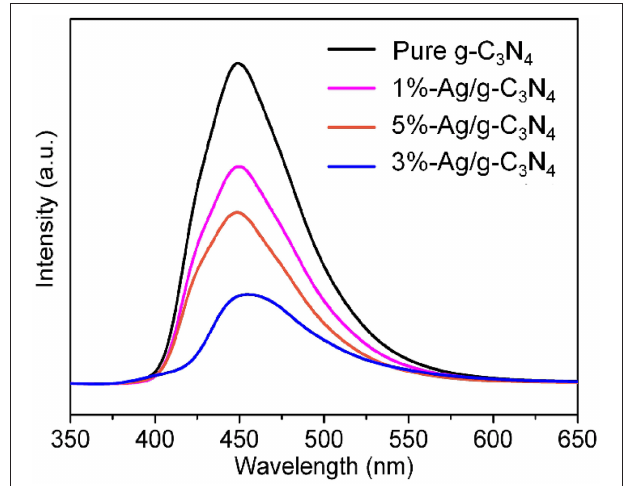
FIGURE 6 | PL spectra of the pure g-C 3 N 4 , 1%-Ag/g-C 3 N 4 , 3%-Ag/g-C 3 N 4 , and 5%-Ag/g-C 3 N 4 sample.